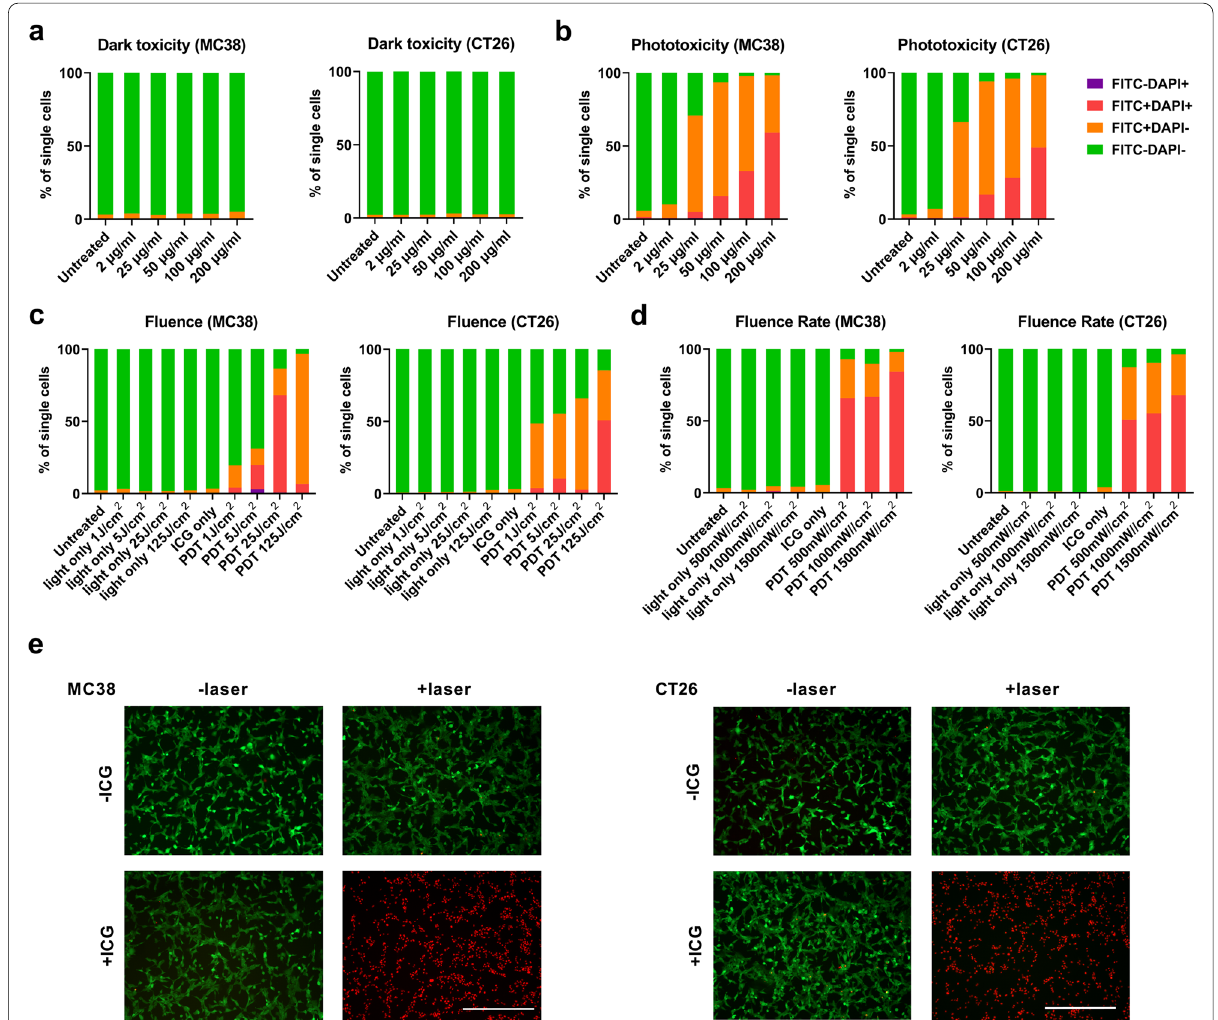
Fig. 2 ICG-mediated cancer cell neutralizing effects in vitro . ( a ) MC38 cells and CT26 cells were incubated with ICG (2 µg/mL-200 µg/mL) for 4 h, followed by washing and overnight incubation to investigate the dark toxicity of ICG. The effect of ( b ) ICG concentration, ( c ) fluence, and ( d ) fluence rate in MC38 cells and CT26 cells, respectively, the in vitro cytotoxicity of ICG-PDT were determined by flow cytometry analysis after staining with DAPI and Annexin V-FITC. Single cells were gated into live cells (FITC − DAPI − ), early apoptotic cells (FITC + DAPI − ), late apoptotic cells (FITC + DAPI + ) and necrotic cells (FITC − DAPI + ). ( e ) PDT effects stained with LIVE/DEAD ™ Viability/Cytotoxicity Kit. 10